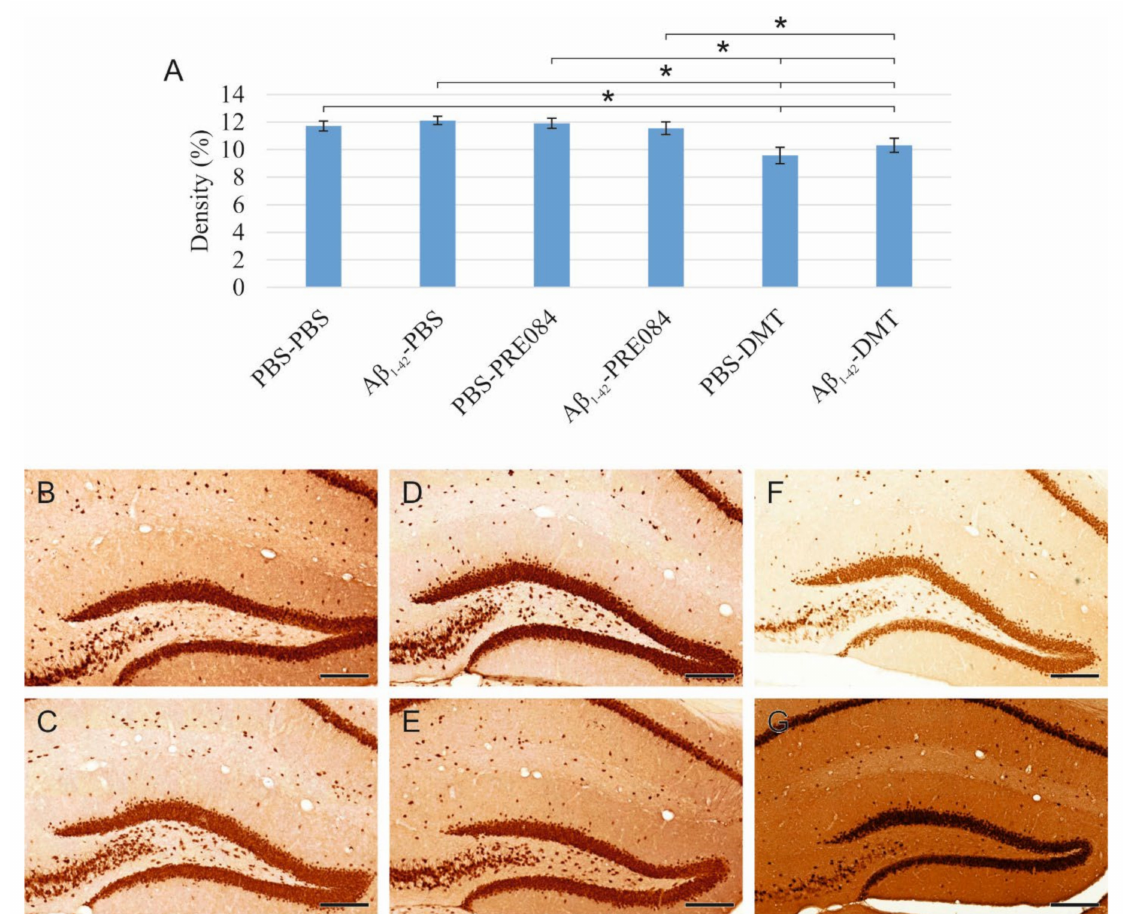
Figure 3. ( A ) Results for neuronal nuclei (NeuN) immunostaining. Significant differences were detected among the groups as follows (ANOVA: p = 0.001): in DMT-treated animals, significantly lower NeuN densities were evident compared to the PBS-PBS and A β 1–42 -PBS groups (PBS-DMT vs. PBS-PBS p = 0.001, vs. A β 1–42 -PBS p ≤ 0.0001; A β 1–42 -DMT vs. PBS-PBS p = 0.022, vs. A β 1–42 -PBS p = 0.003). Furthermore, significant differences were found when the groups were compared to the PBS-DMT-treated group: PBS-DMT vs. PBS-PRE084 p = 0.001, vs. A β 1–42 -PRE084 p = 0.006; A β 1–42